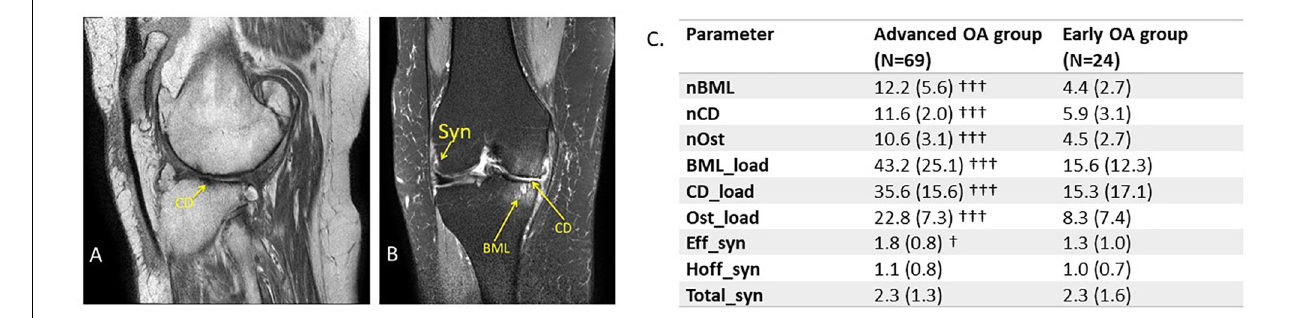
FIGURE 1 | Measurement of MOAKS scores in subjects with knee OA. (A) Representative MRI scans acquired at 3T with an eight channel knee coil for patients with advanced OA. (A) Sagittal T1-weighted image with TE 15 ms, TR 600 ms, Subject 38, average cartilage damage score (CD_load) = 94. (B) Coronal intermediate weighted image with TE 30 m, TR 5000 ms, fat saturation, 0.35 mm in plane resolution, 3 mm slice thickness, 0.25 mm slice gap, SENSE factor 1.4. Subject 58, total synovitis score (total_Syn) = 3 (range 0–6), whole knee scores for BML (BML_load) = 44 (range 0–125), CD (CD_load) = 46 (range 1–94), and osteophytes (Ost_load) = 19 (range 0–38). Ranges given are the minima and maxima over the whole patient data set. (C) Comparison of MOAKS’ defined structural damage in knee OA in advanced versus mild OA. Significant differences by Mann–Whitney U -test were: † p < 0.05, ††† p < 0.001 between advanced and early OA groups.